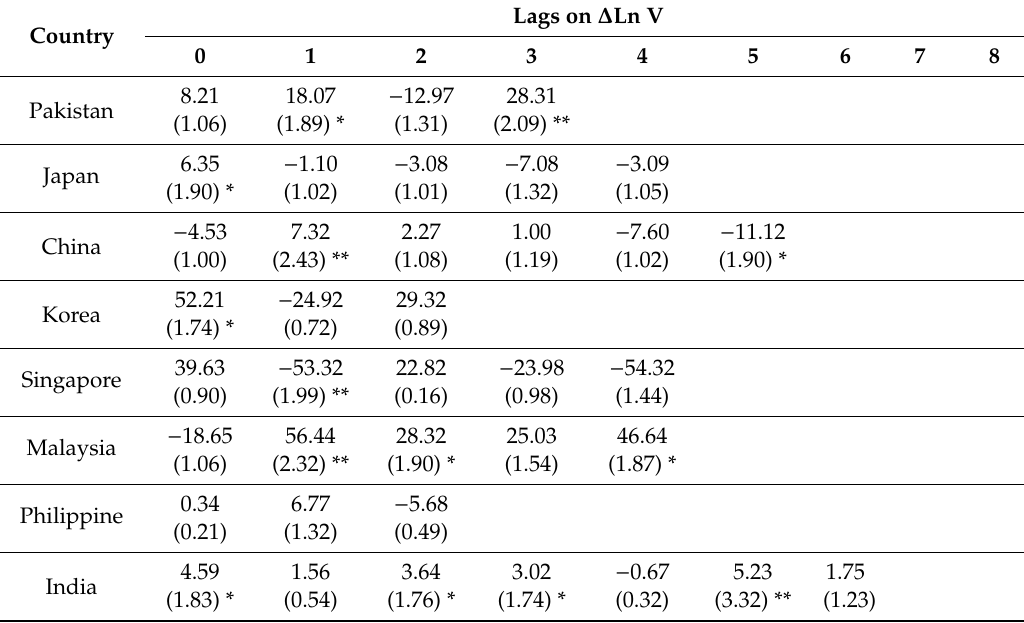
Table 3. Short-Run Coe ffi cient Estimates of Volatility on Imports: Estimates from the Linear Import Demand Model